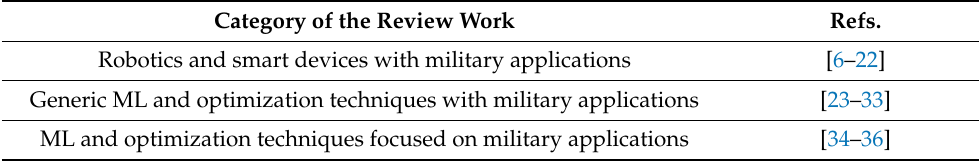
Table 1. Related review work. Category of the Review Work